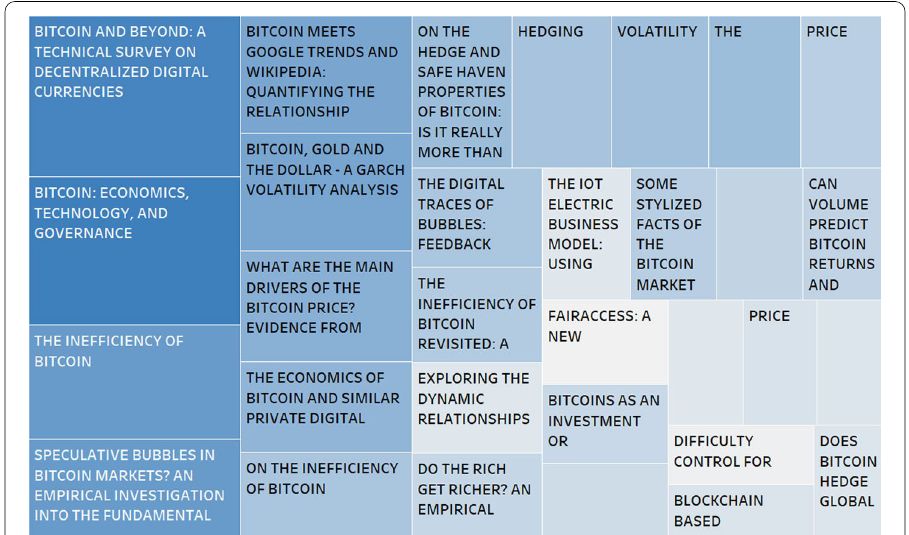
Fig. 2 Most Cited articles in both databases. Source : Own